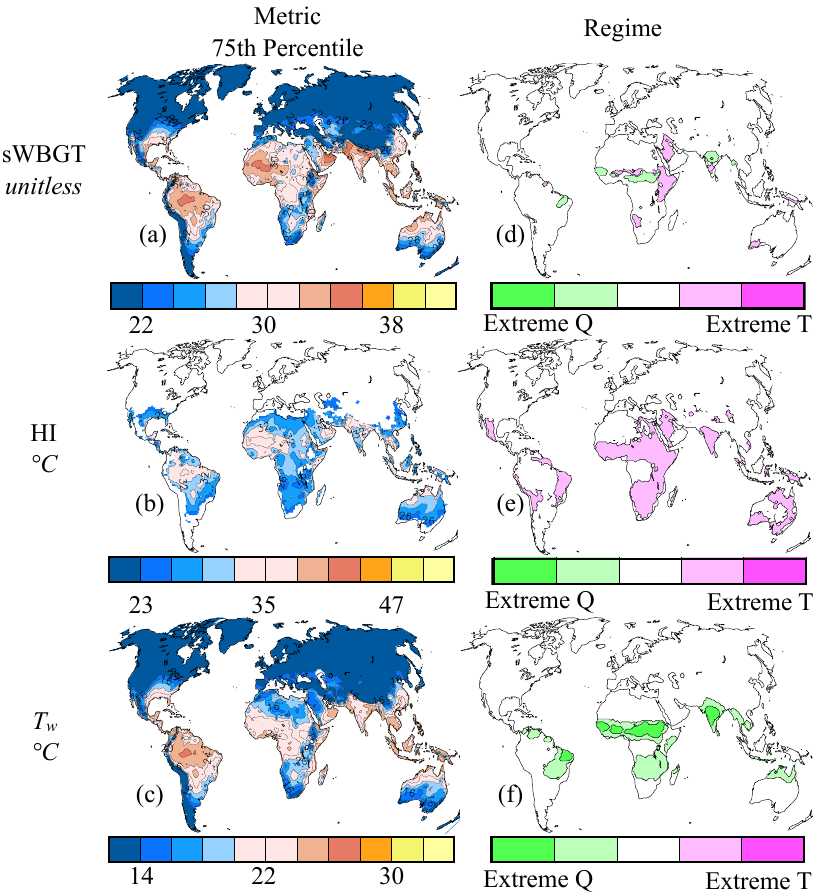
Figure 3. 75th percentile exceedance value of three metrics for (a) sWBGT, (b) HI, and (c) T w (left). Expected rank value T − Q regime maps (d) , (e) , and (f) (right) conditioned by (a) , (b) and (c) , respectively. Rank values for (d) – (f) are described in Fig. 2.